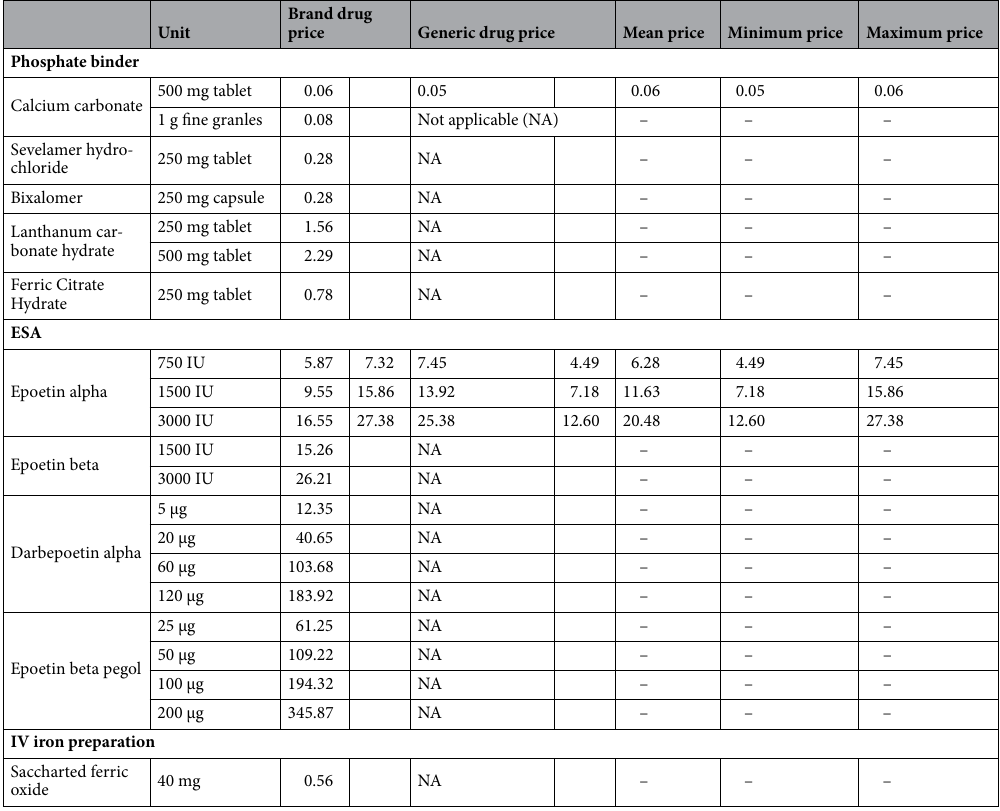
Table 2. The unit prices of drugs (US$). Source: Hokenyaku Jiten Aug 2016.